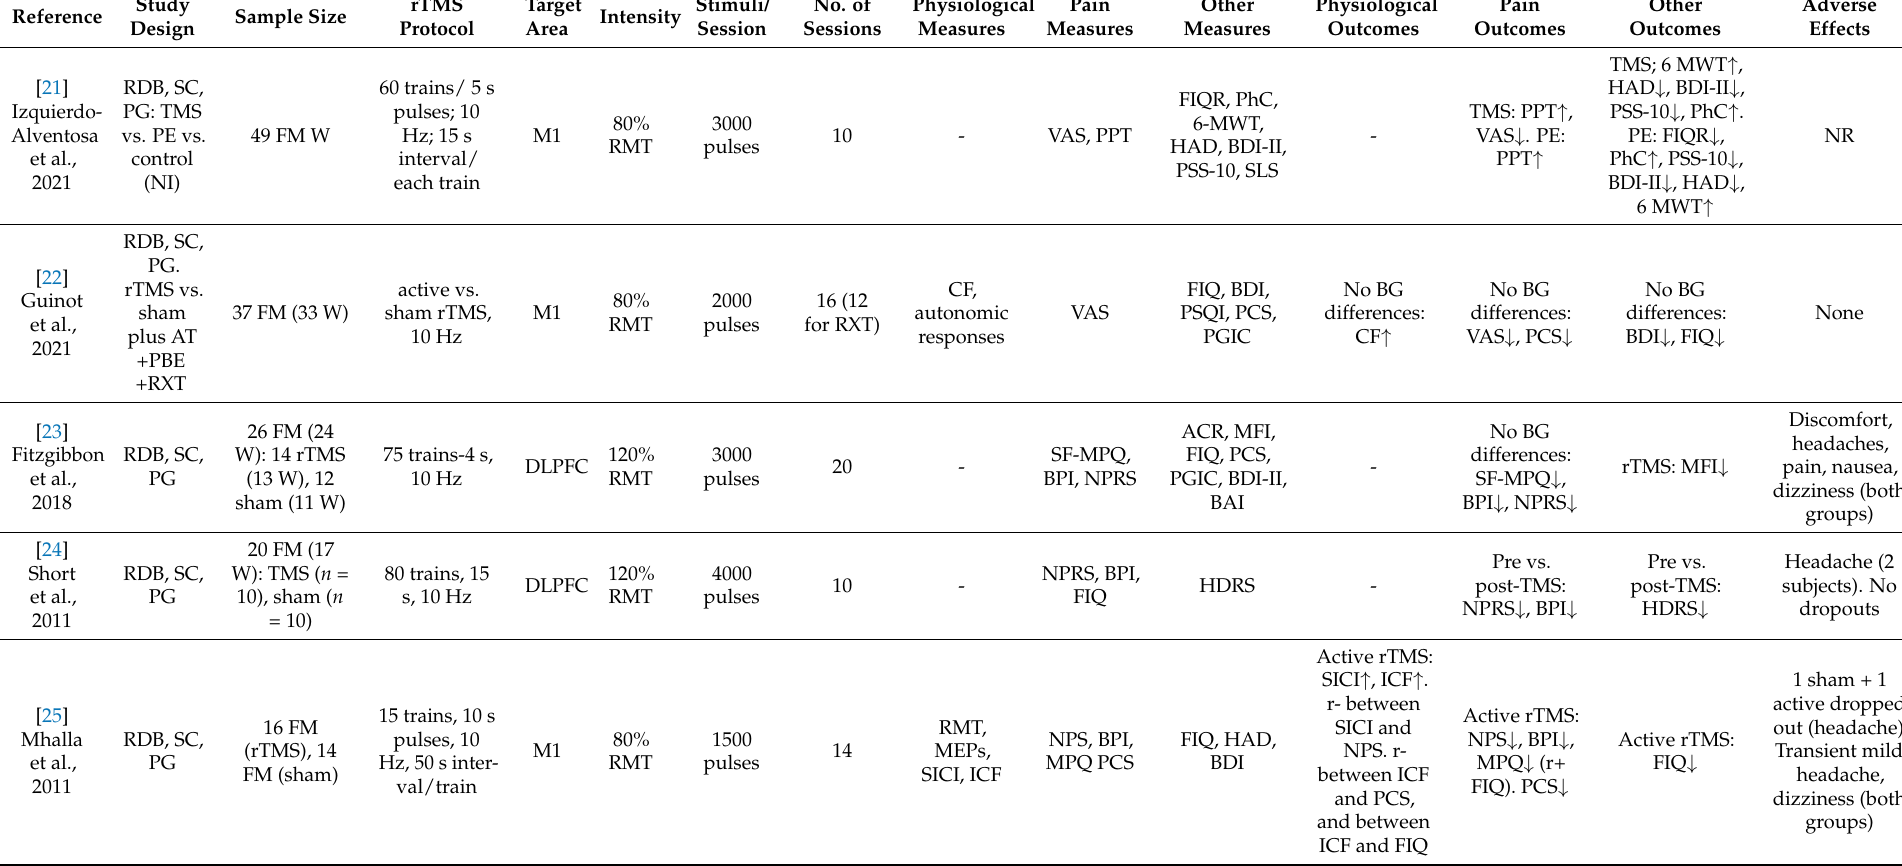
Table 2. Protocols and results of relevant studies conducted to explore rTMS effects on fibromyalgia